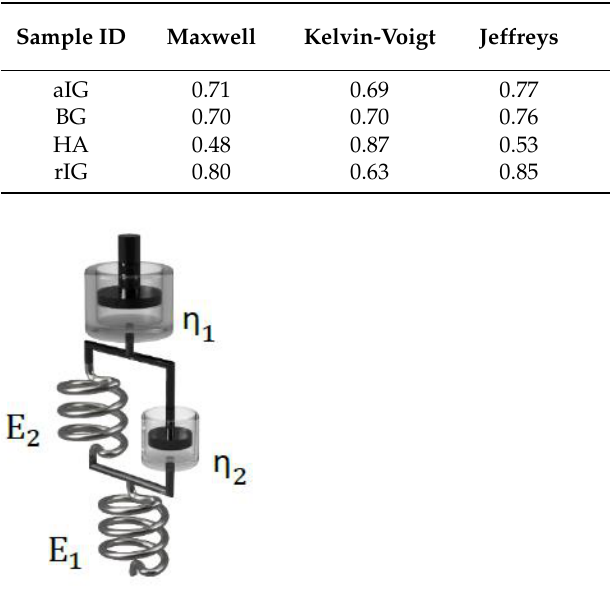
Figure 6. Schematic illustration of the Burgers rheological model.